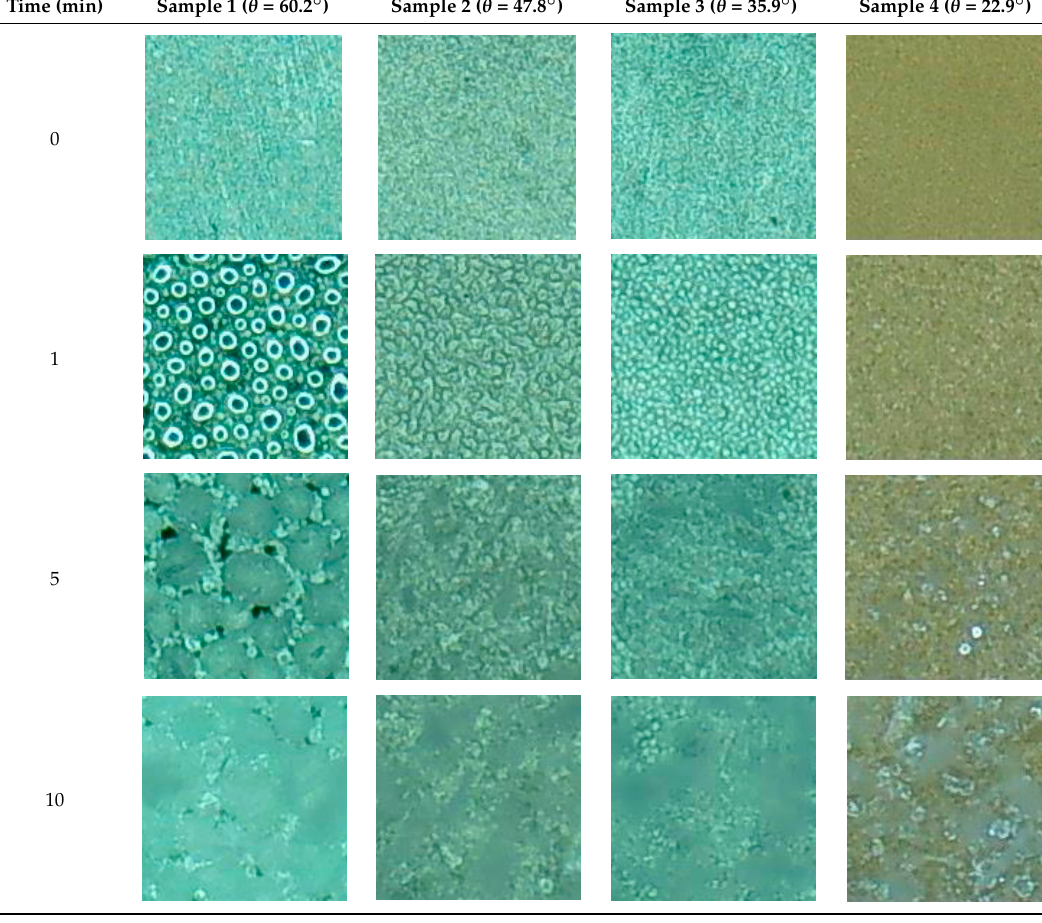
When frosting at 1 min, there were some spherical droplets, with different sizes, formed on the surface of Sample 1. The average radius of the droplets was the biggest on Sample 1. Many irregular droplets formed on the surface of Sample 2. There were many small spherical droplets on the surface of Sample 3. However, there were no obvious droplets on the surface of Sample 4; but we could see some sparse white spots on Sample 4, which were actually tiny droplets. Droplet density increased from Sample 1 to Sample 4, respectively. It revealed that when the surface contact angle decreased, the droplet density on the aluminum surfaces